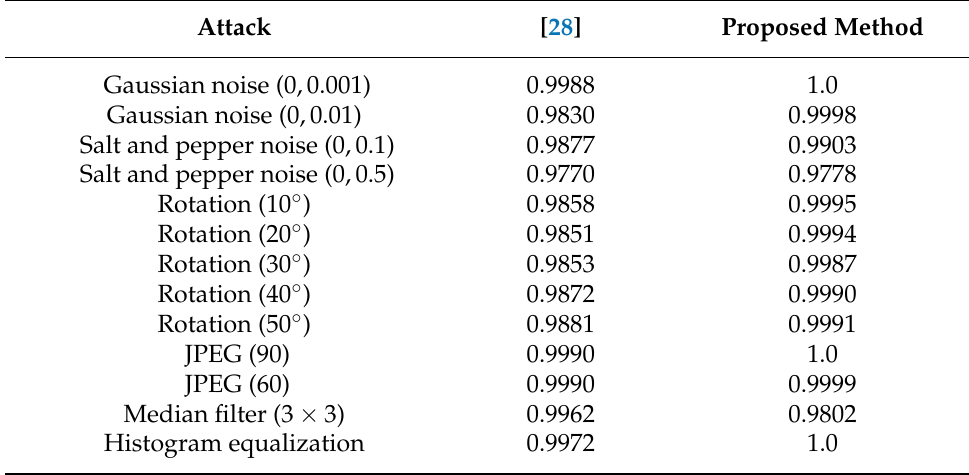
Table 15. Robustness comparison measured with [28] in terms of NC for Lena